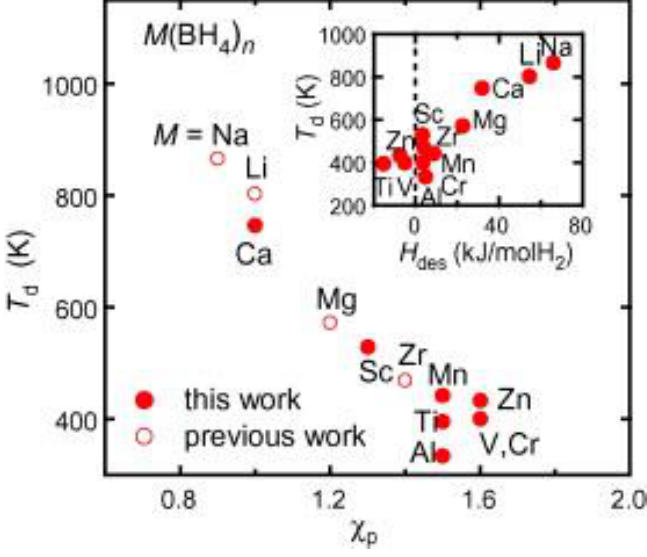
Figure 8. The dehydrogenation temperature, T d as a function of the Pauling electronegativity χ p for selected metals. The inset shows the correlation between T d and estimated H des for the desorption reaction [73]. Reprinted with permission from [73], copyright 2007